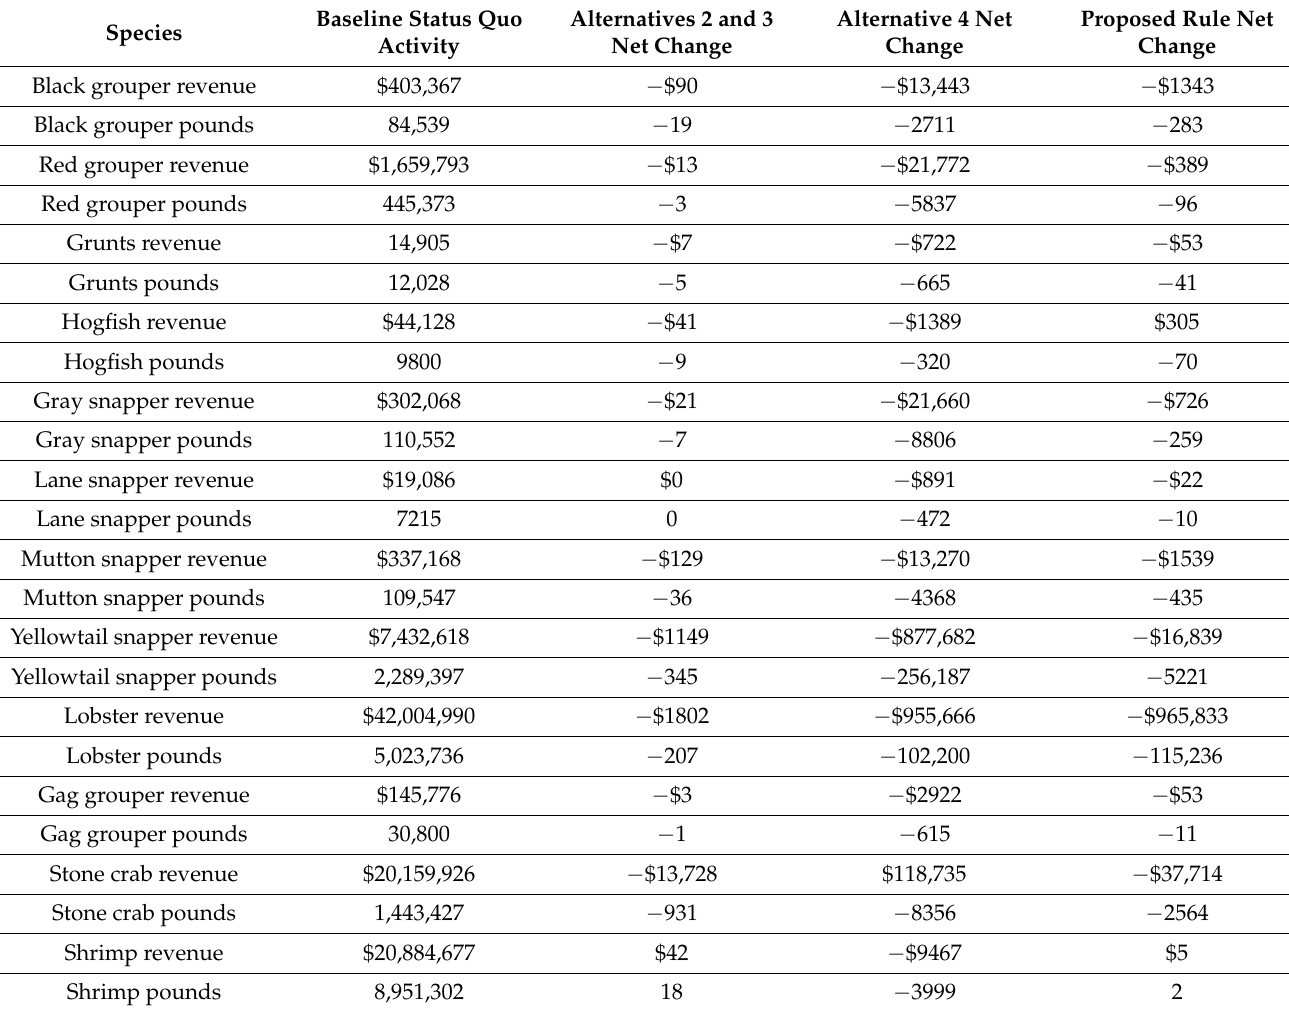
Table 1. Baseline value and pounds of landings from Monroe County waters and maximum potential loss by alternative (monetary estimates in 2019